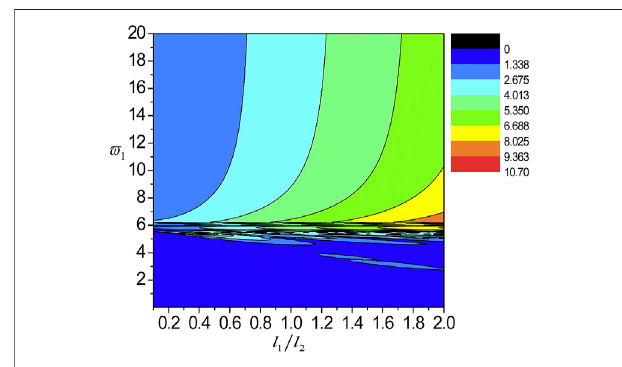
FIGURE 13 | The localization factors varying with the normalized frequencyand l 1 / l 2 fortheSHwavepropagatingnormallyinthenanoscaleCu/ Al Fibonacci laminate for τ 1 = τ 2 = 0.18.